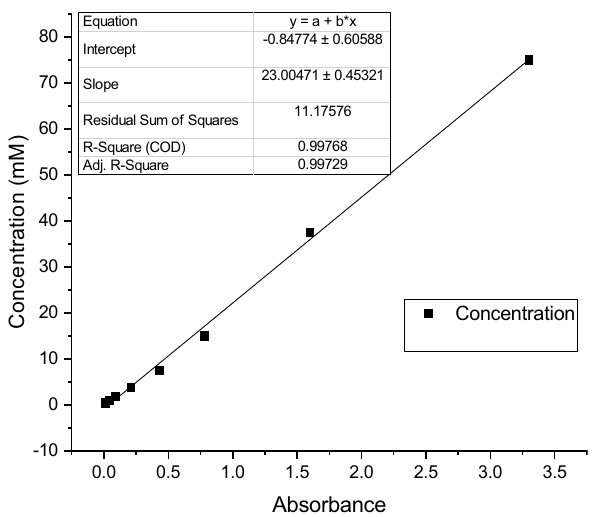
Figure 2. Standard curve for sulfide concentration.